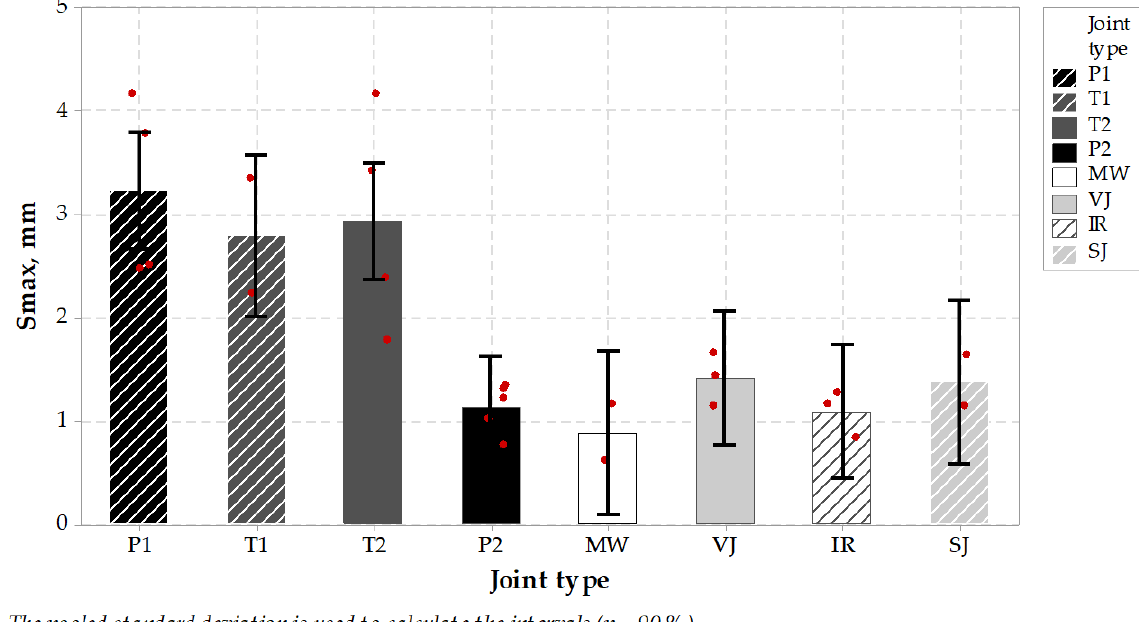
Figure 8. Indirect tension maximum elongation test results of specimens taken from longitudinal joints.